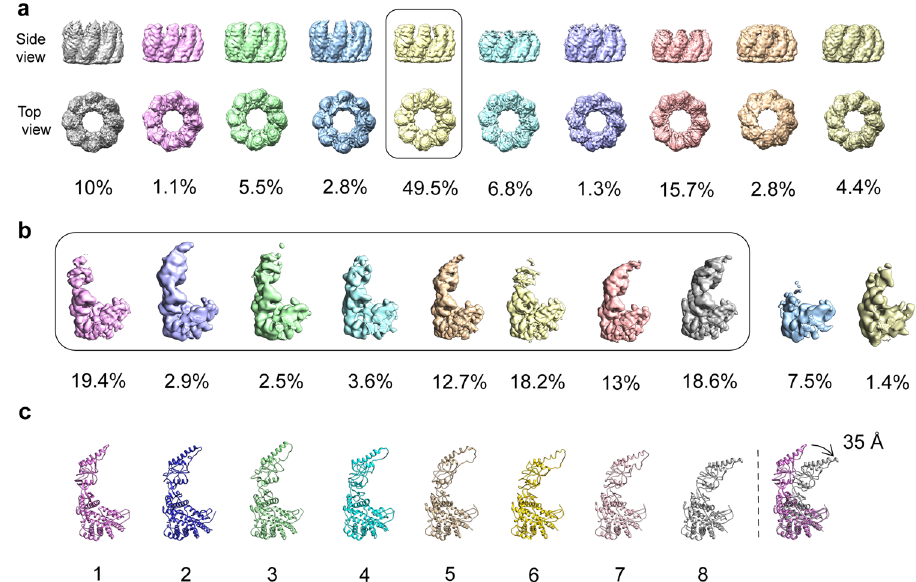
Fig. 2 Focused classi fi cation of conformational heterogeneity. a Single ring-focused classi fi cation into ten classes. The ring class outlined in black is selected for further analysis in ( b ). b Subunit-focused classi fi cation into ten classes of individual subunits. The subunit classes outlined in a black box are selected for modeling in ( c ). c Fitted models for corresponding subunit maps shown in ( b ). The distal tip of the apical domain moves inwards ~35 Å between the most open conformation (class 1) and the most closed conformation (class 8) (shown in the far right model with class 1 and 8).